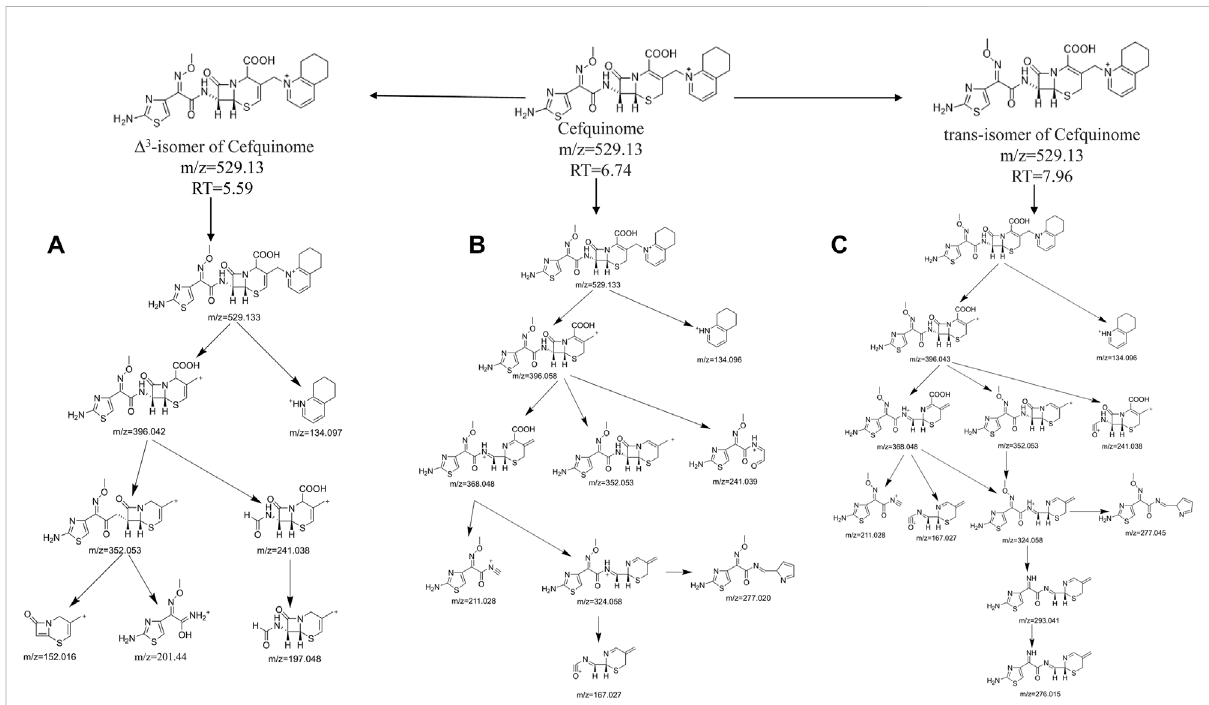
FIGURE 3 The proposed fragmentation pathways of Cefquinome (B) , Δ 3 -isomer of Cefquinome (A) , and E-isomer of Cefquinome (C) in the positive ion